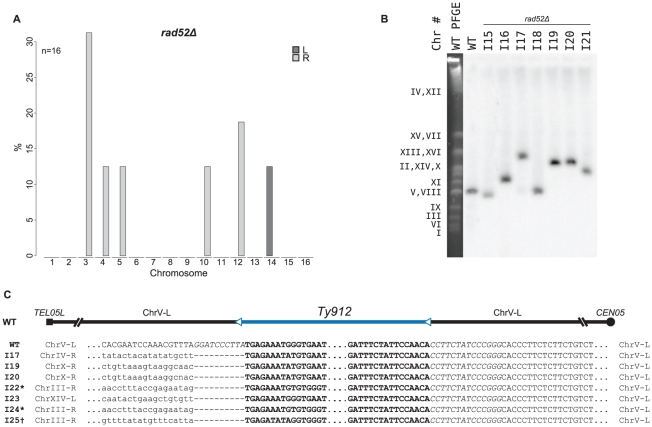
MLPA, Southern blot, and sequencing analyses of GCRs derived from a rad52Δ recombination-deficient mutant strain.A. MLPA data reveals duplicated chromosome arms associated with GCRs derived in a rad52Δ mutant strain. B. Southern blot of a Pulse Field Gel with separated chromosomes from GCR-containing isolates from a rad52Δ mutant strain also reveals larger than wild-type chromosome Vs (I16, I17, and I19–I21). C. Pseudo multiple sequence alignment of sequenced breakpoint junctions from rad52Δ derived GCRs. Italicized base pairs flanking Ty912 on chromosome V represent nonreference-sequence restriction sites used for cloning and inserting Ty912 on chromosome V. * - sequence upstream of the 5′ end of the Ty- element mediating the translocation matches part of the reference sequence supposedly deleted by FS2; this suggests that the FS2 loci is not completely identical to that described originally in [15]. † Amplified fragment is consistent with two tandem Tys in FS1; however, the 5′ flanking sequence displayed is part of the tandem Ty1 construct and was what was read when the 5′ primer used to amplify the fragment was used to sequence the fragment.